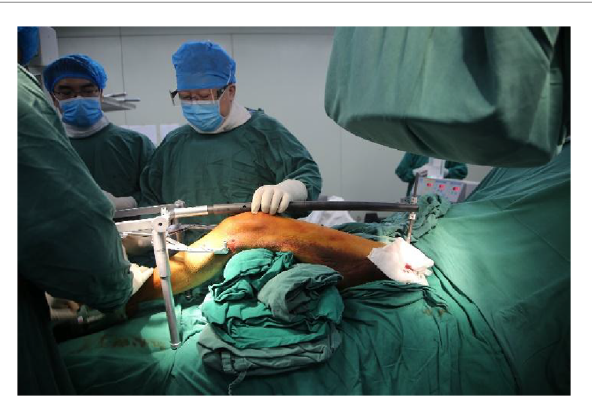
FIGURE 3 Reduction of fracture with double-reverse traction reducer during